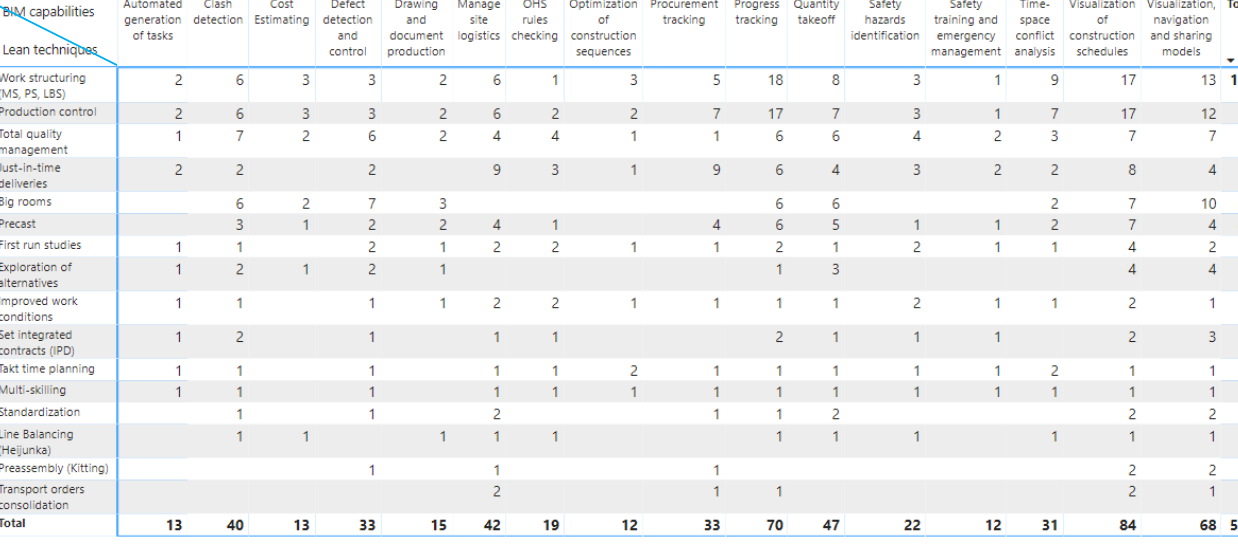
Figure 4. Lean construction and BIM interactions weighting matrix.